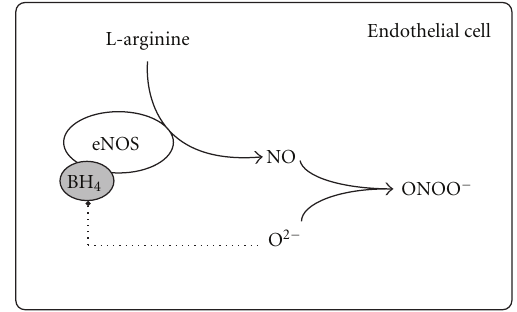
Figure 1: Simplified schematic depicting mechanisms by which reactive oxygen species can reduce nitric oxide (NO) availability. NO is synthesized from eNOS and can combine with excess superoxide (O 2 − ) from vascular oxidases to form peroxynitrite (ONOO − ) limiting NO availability. Superoxide can also oxidize the eNOS cofactor tetrahydrobiopterin (BH 4 ), uncoupling eNOS and reducing NO